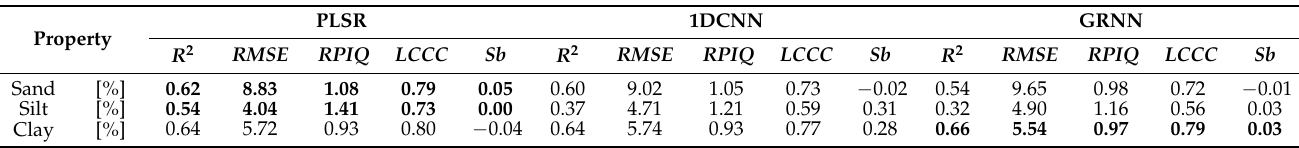
Table 1. Summary of validation statistics for models in the “Texture” group. The best prediction result for particular variables is marked in